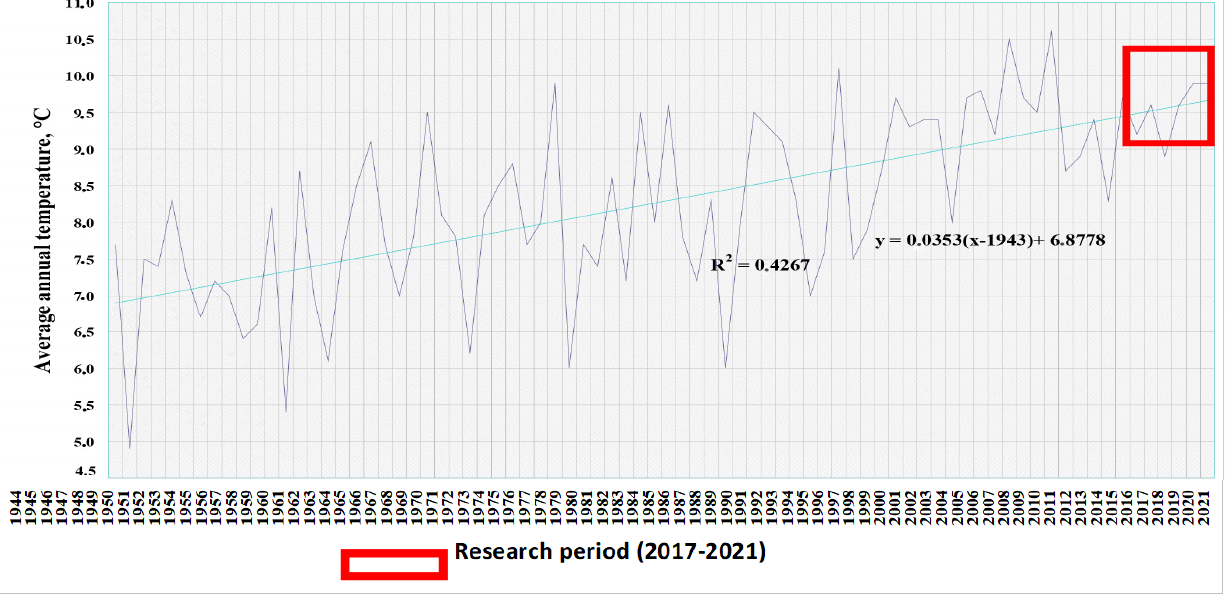
Figure 2. Average annual temperatures according to the Volgograd weather station for 1944–2021. The red box highlights the research period (2017–2021).